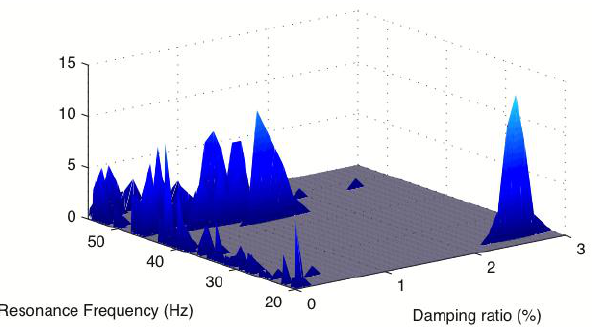
Fig. 12. Clusters of estimated poles from Auto/cross-powers.